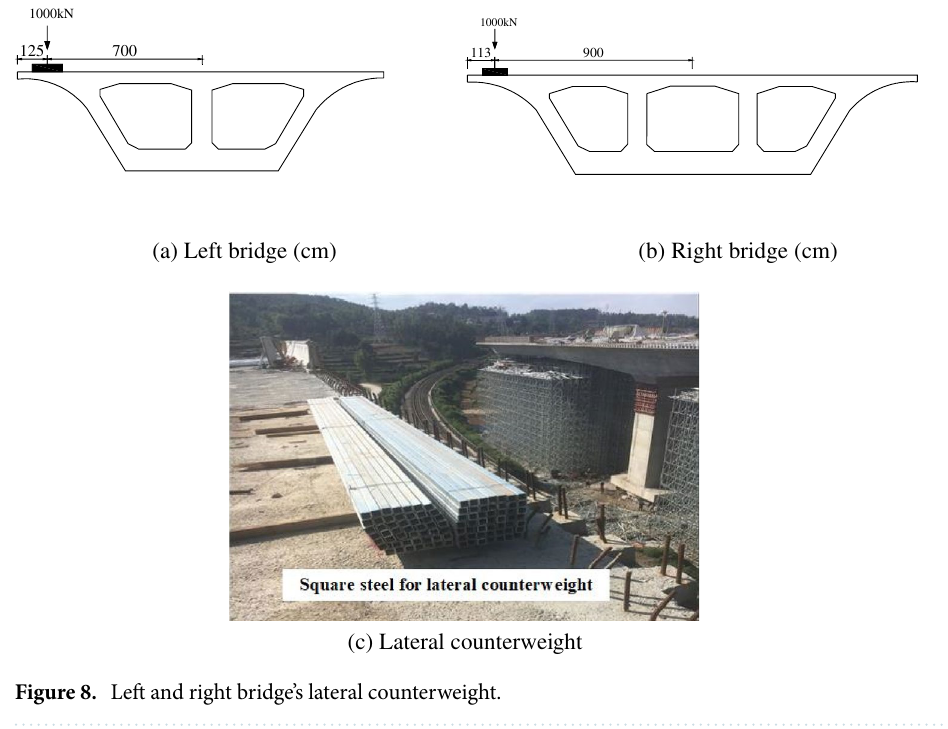
Figure 8. Left and right bridge’s lateral counterweight.